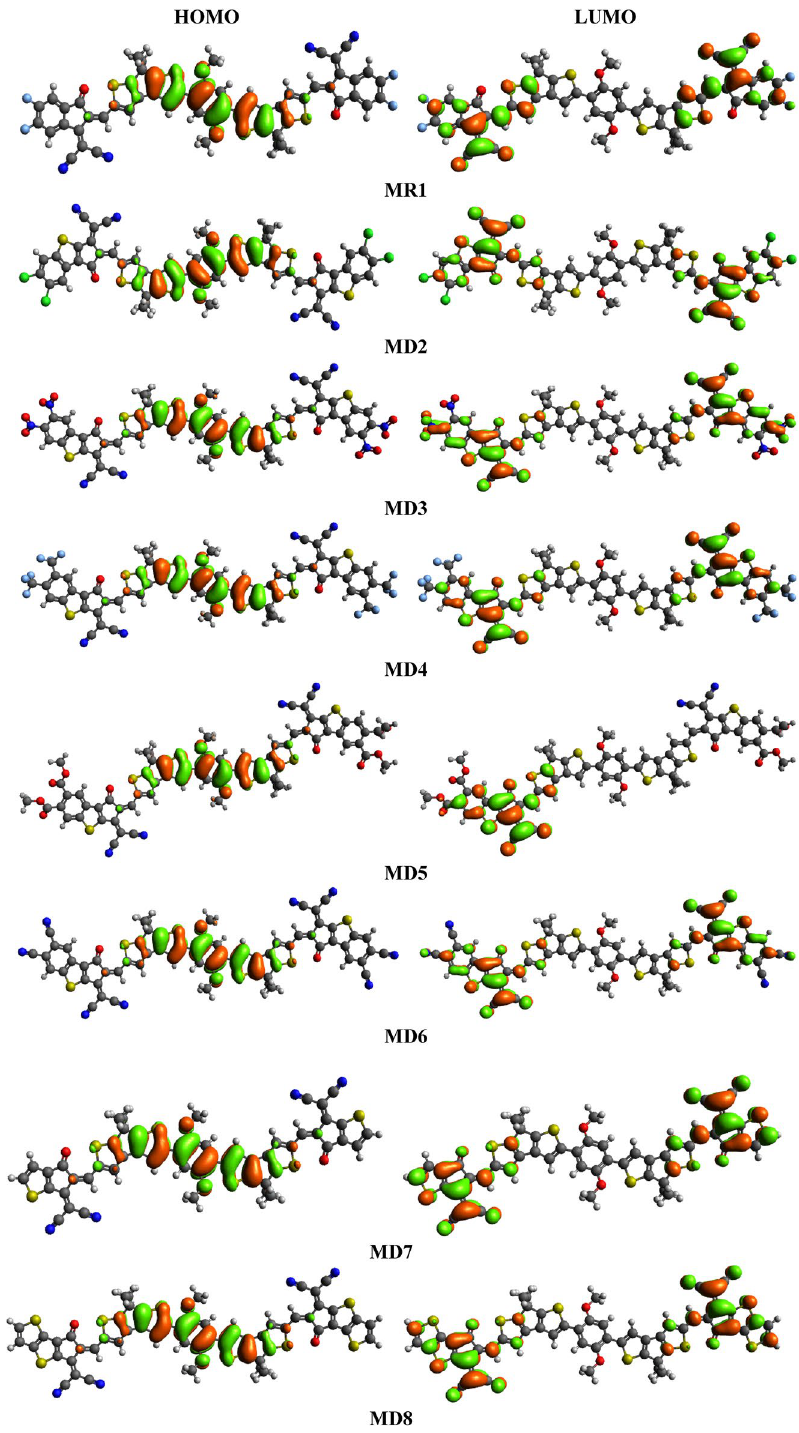
Figure 4. The FMOs (HOMOs & LUMOs) of the MR1 and MD2–MD8 drawn with the help of Avogadro software, Version 1.2.0. (http:// avoga dro. cc/). All out put files of entitled compounds were accomplished by Gaussian 09 version D.01 (https:// gauss ian. com/ g09ci